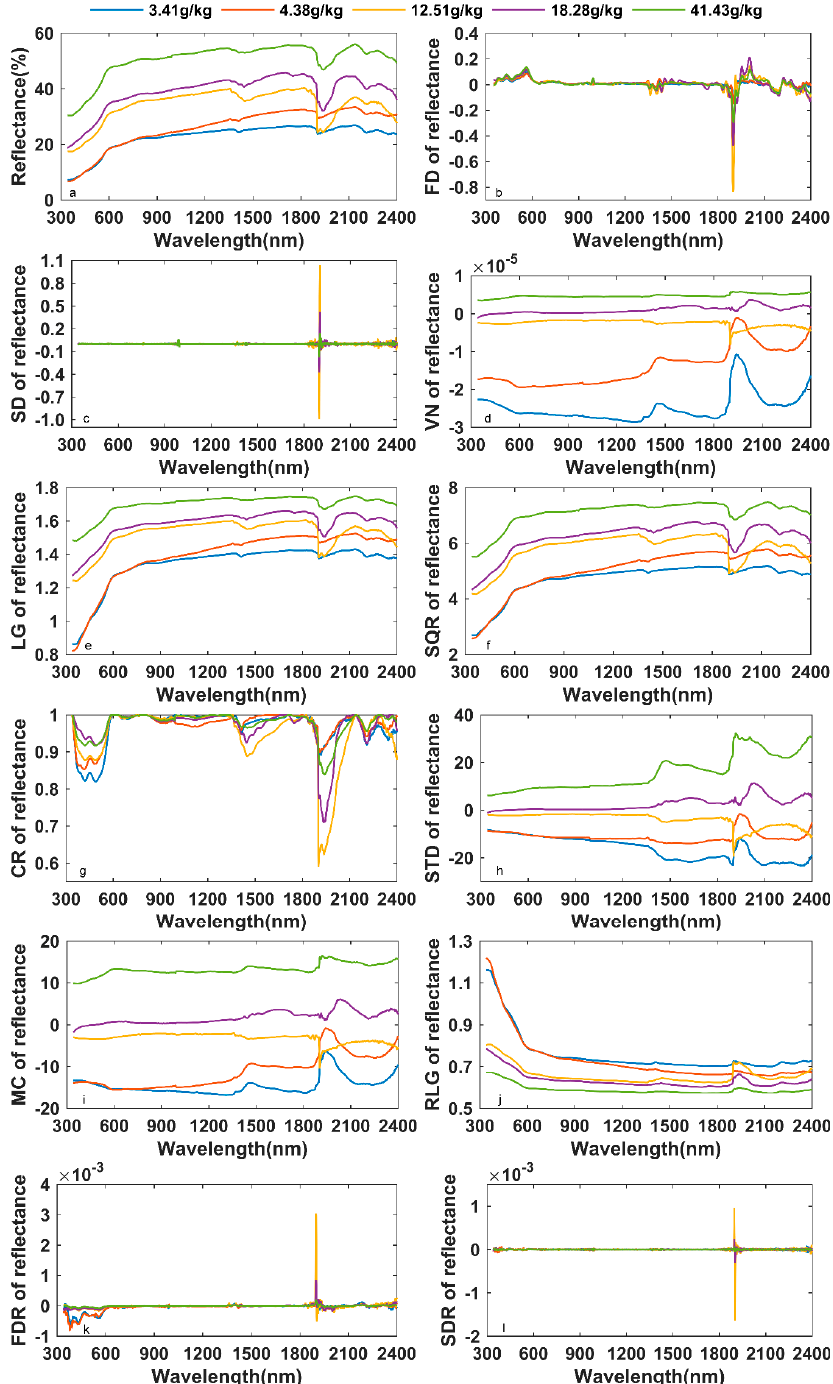
Figure 6. Spectral transformation curve ( a ) the raw reflectance spectra (RS), ( b ) the first derivative of the reflectance spectra (FD), ( c ) the second derivative of the reflectance spectra (SD), ( d ) the vector normalization of the reflectance spectra (VN), ( e ) the logarithm of the reflectance spectra (LG), ( f ) the square root of the reflectance spectra (SQR), ( g ) the continuum removal of the reflectance spectra (CR), ( h ) the standardization of the reflectance spectra (STD), ( i ) the mean center of the reflectance spectra (MC), ( j ) the reciprocal of logarithm of reflectance spectra (RLG), ( k ) the first derivative of reciprocal of the reflectance spectra (FDR), and ( l ) the second derivative of the reciprocal of the reflectance spectra